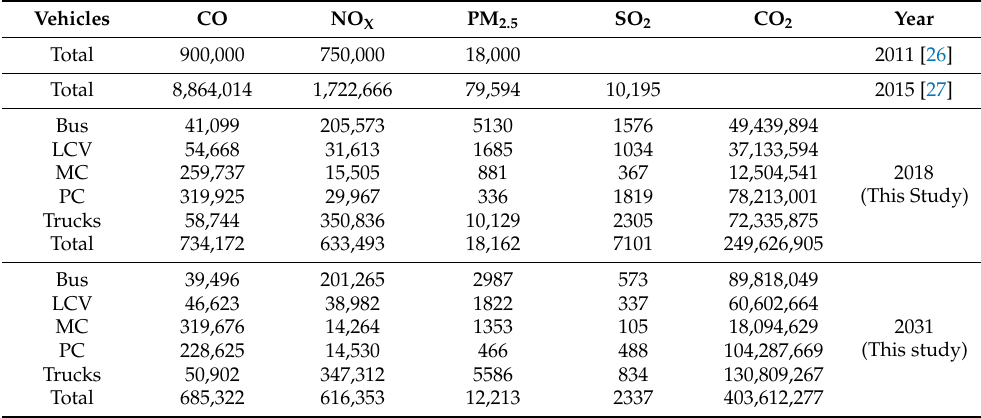
Table 1. Vehicular emissions in Brazil by type of vehicle in 2011, 2015, 2018, and 2031 (t/year). Vehicles CO NO X PM